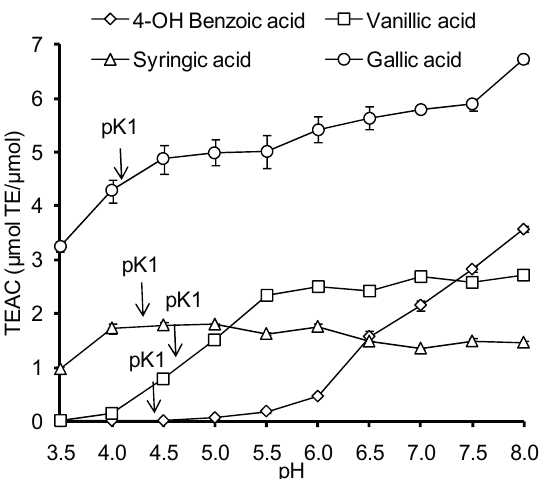
Figure 3. pH-Dependence of AOC against the ABTS radical cation for HB and HC acids.